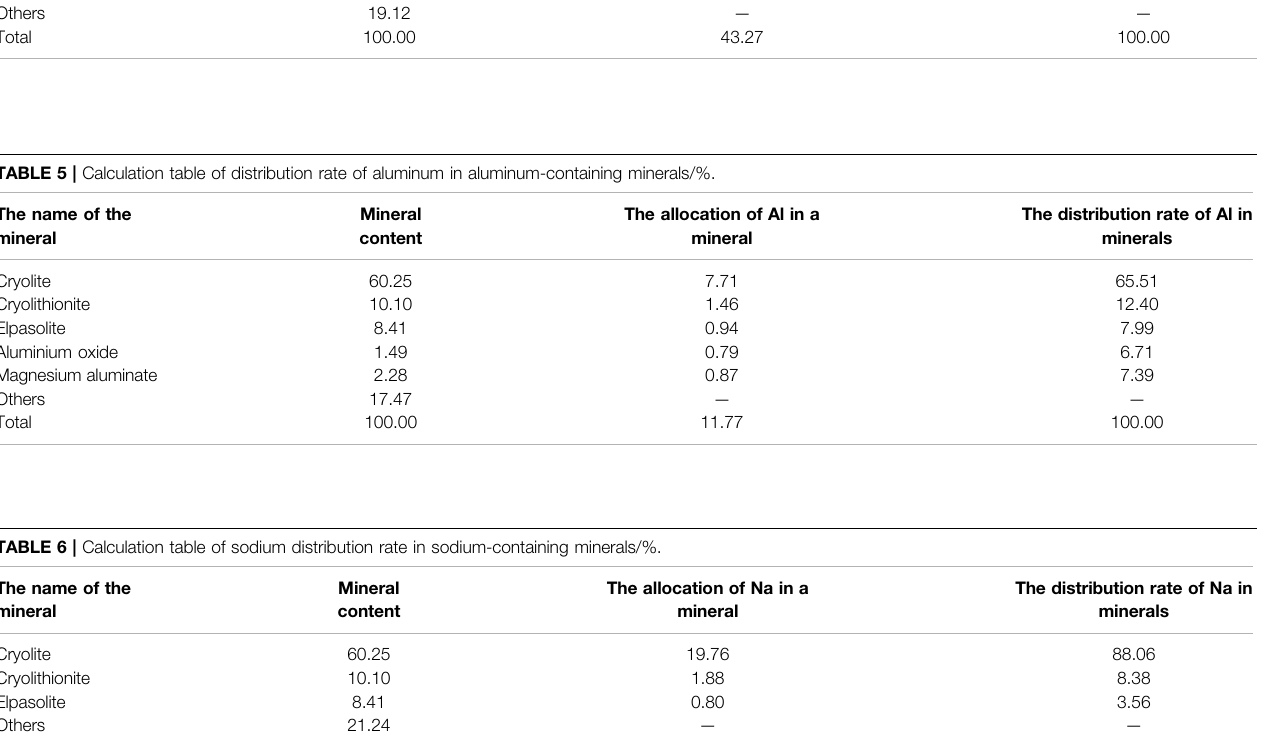
TABLE 4 | Calculation table of the distribution rate of fl uorine in fl uorine-containing minerals/%. The name of the mineral